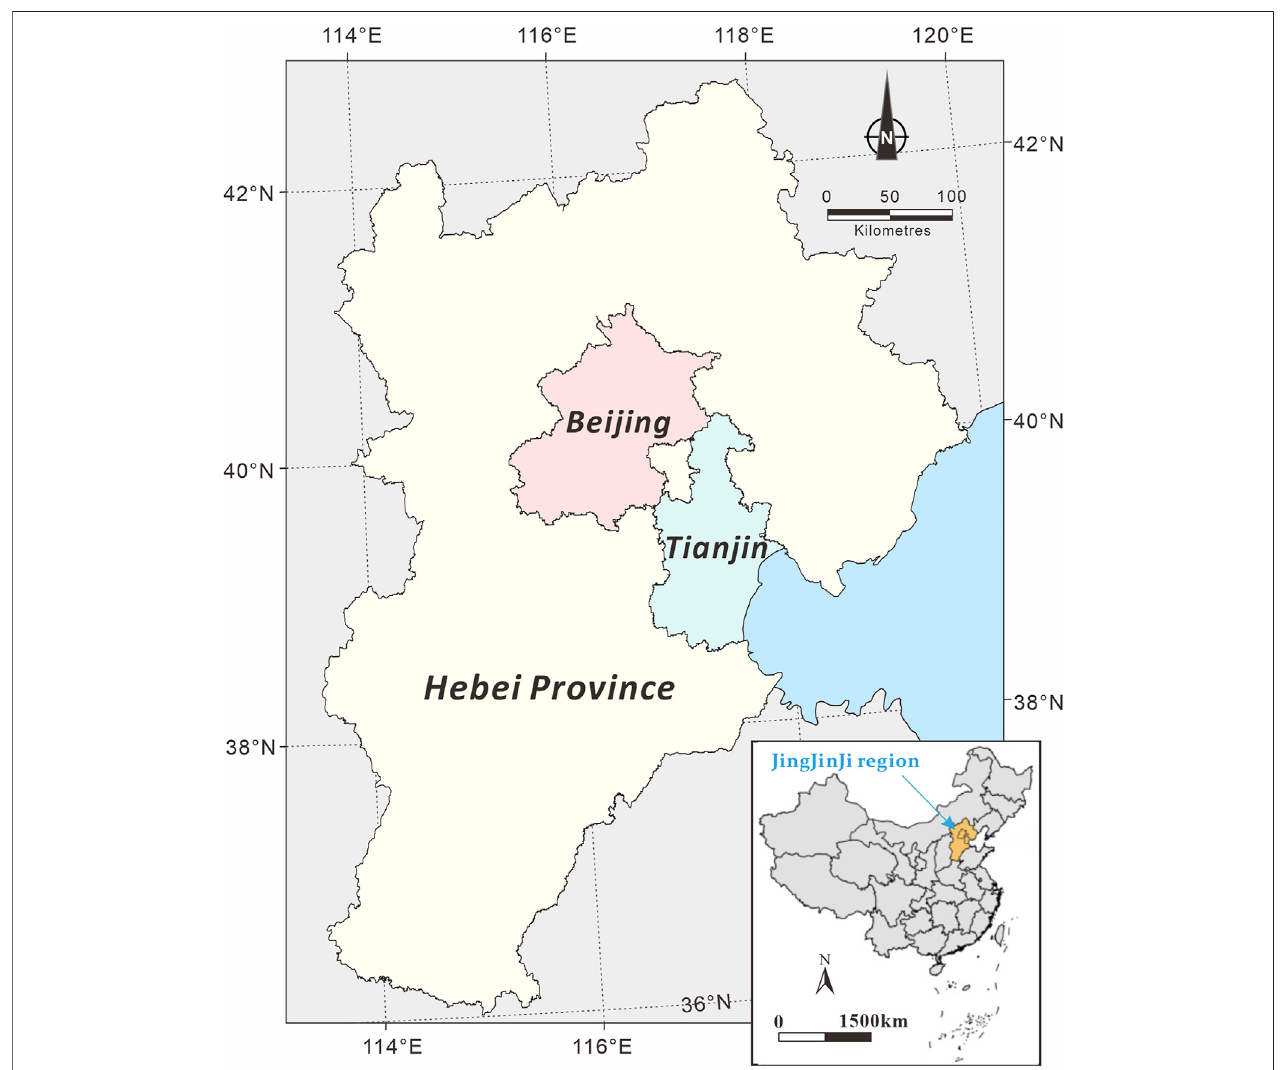
FIGURE 1 | Geographical location of Hebei Province. The map is modi fi ed from (Yao 2017).